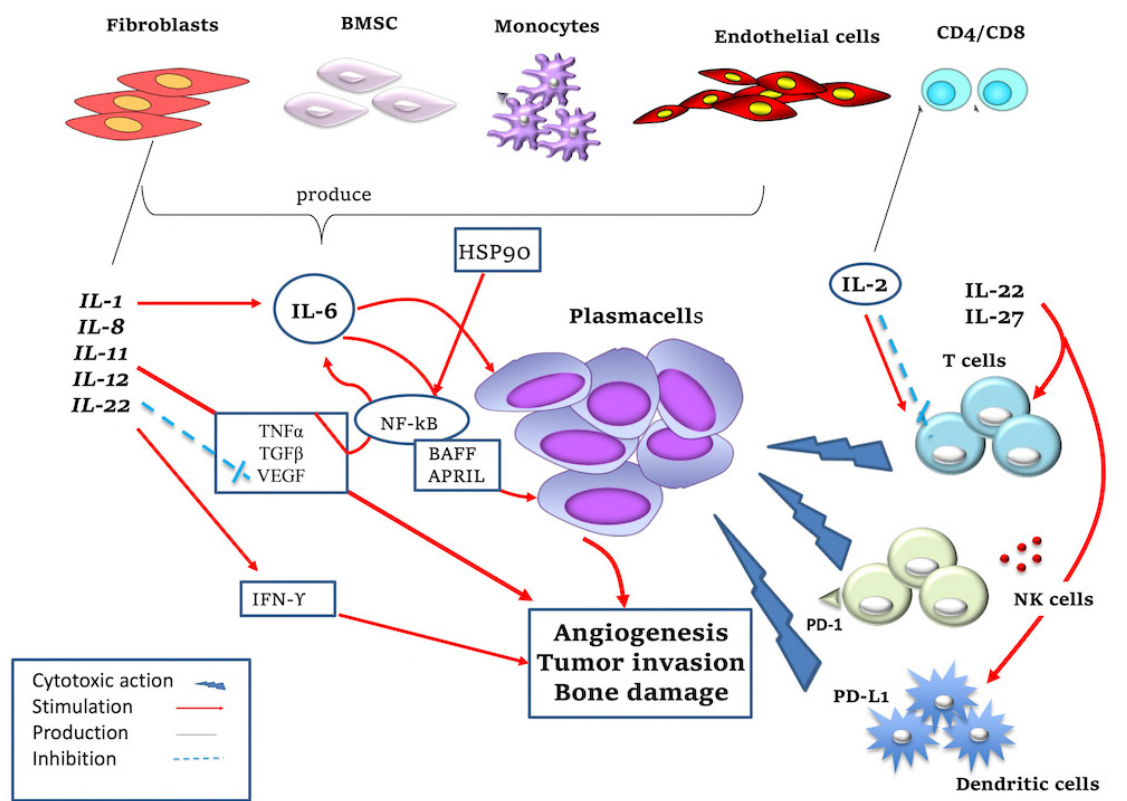
Figure 1. Mechanism of action of pro- and anti-inflammatory cytokines. IL-1, produced by various cell types in the BM microenvironment (i.e., fibroblasts, B lymphocytes), promotes PCs’ survival by stimulating IL-6 production. IL-2 is produced by CD8 + and CD4 + T lymphocytes and promotes the growth of T and NK cells but at the same time induces apoptosis of T cells; it also stimulates the cytotoxic action of NK cells against malignant PCs. IL-6 promotes the growth of MM PCs and resistance to apoptosis; IL-6 is secreted by BMSCs, monocytes, endothelial cells, macrophages and fibroblasts thanks to the action of TGF- β , TNF- α , VEGF, IL-1. IL-1 and TNF are potent inducers of IL-6 synthesis. In detail, they regulate IL-6 gene expression at the level of transcription, which is mediated by upregulation of NF-kB activation. IL-6 stimulates the production of APRIL and BAFF, which activate NF-kB, phosphatidylinositol-3 (PI-3) kinase/AKT and MAPK pathways, promoting MM cells’ survival. IL-8 has a pro-tumor function promoting angiogenesis and tumor invasion. IL-11 promotes tumor invasion and in particular bone damage. IL-12 stimulates the production of IFN- γ with both pro-inflammatory and anti-angiogenic roles and this inhibits the production of VEGF. IL-22 is produced by T lymphocytes, activates the innate immune system and also regulates cell proliferation and resistance to drug-induced cell death in MM cells. IL-27 has antitumor activity, causing increased proliferation and differentiation of T cells. IL-27 stimulates the expression of immune checkpoint inhibitor programmed death (PD)-1 or PD-L1 in different cell types (i.e., lymphocytes and dendritic cells) and increases NK cells’ activity. HSP and HSP90 are produced by macrophages/monocytes and promote MM cell survival through TNF-mediated and NF-kB signaling pathways.